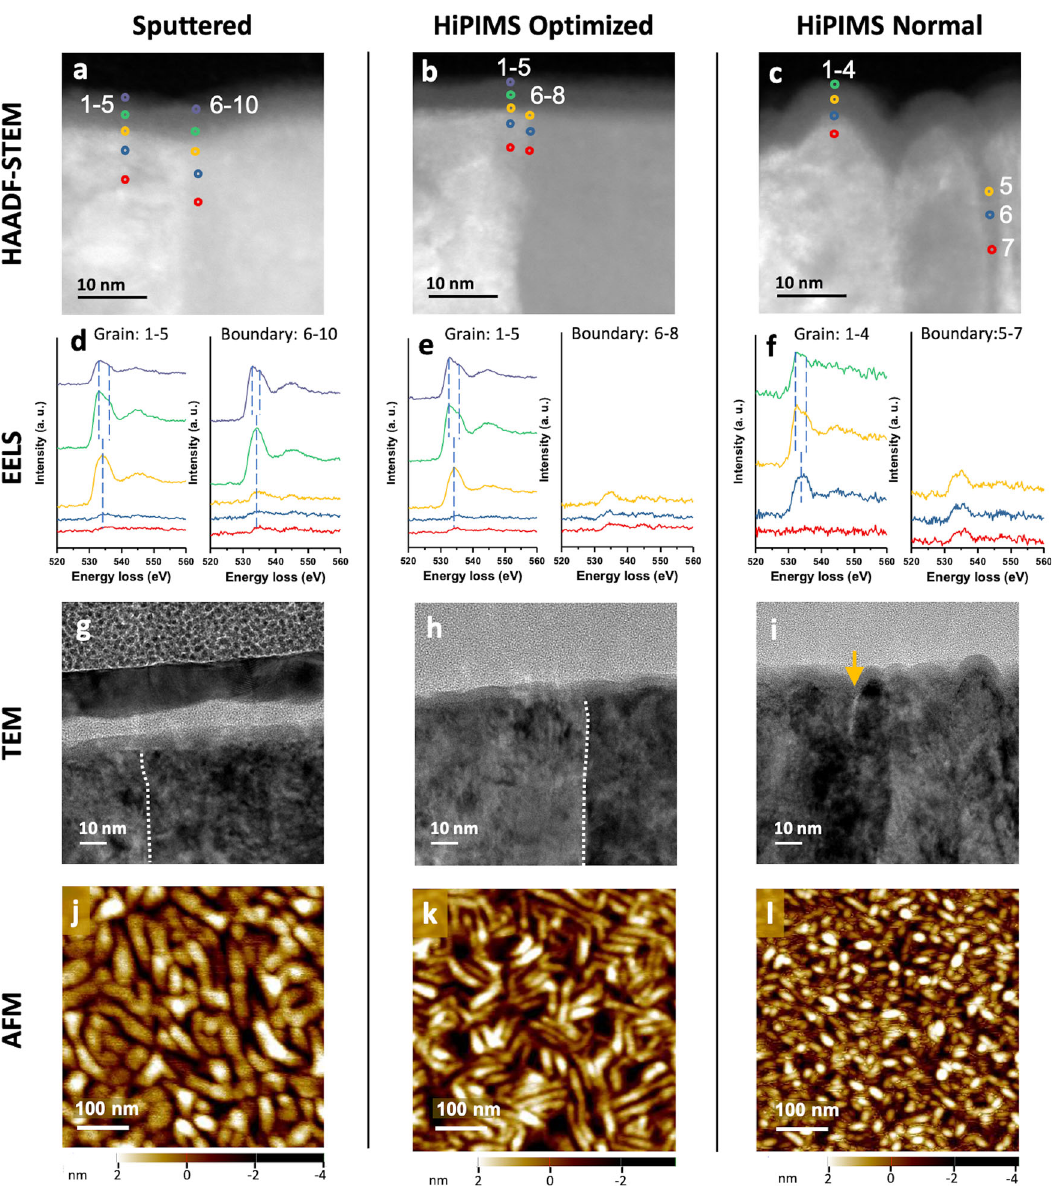
Fig. 5 Structural and chemical imaging of the three types of Nb fi lm. All measurements are shown for the sputtered, HiPIMS optimized, and HiPIMS normal fi lms, respectively. Panels ( a ) – ( c ) show high-angle annular dark- fi eld scanning transmission electron microscopy (HAADF-STEM) measurements at cross-sections of the fi lms' surfaces, revealing a ≈ 5 nm oxide layer and variations in grain size. Panels ( d ) – ( f ) show O- K -edge electron-energy loss spectroscopy (EELS) spectra measured at the locations indicated on the HAADF-STEM images. For the sputtered and HiPIMS optimized fi lms, both the EELS spectra within a grain (left) and the spectra taken along a grain boundary (right) show a transition from a double peak (Nb 2 O 5 ) to a single peak (suboxides) to a negligible peak (metal). However, for the HiPIMS normal fi lm, EELS spectra along the grain boundary reveal similar oxidation peaks to the surface oxide layer, indicating that oxygen has diffused into the grain boundary to form oxides. Panels ( g ) – ( i ) show TEM bright- fi eld images of cross- sections of the fi lms' surfaces, where the white dotted lines delineate grain boundaries for the sputtered and HiPIMS optimized fi lms, and the yellow arrow points to a gap at the grain boundary for the HiPIMS normal fi lm. The grainy, light gray layer above the surface is platinum, which protects the surface during sample preparation. Panels ( j ) – ( l ) show atomic force microscopy (AFM) images measured over a 500 nm x 500 nm area. It is visually evident that the sputtered fi lm grain size is the largest, and the HiPIMS normal fi lm grain size is the